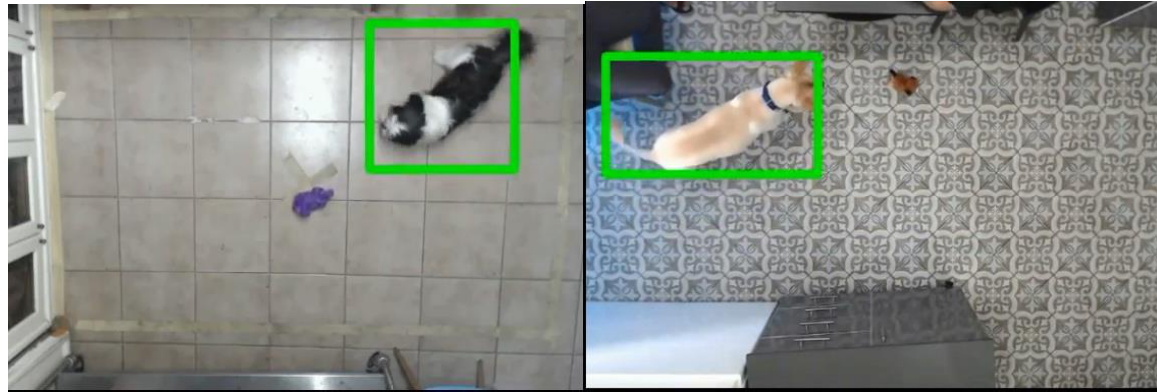
Figure 4 . Example frames of K9-Blyzer identification of two subjects.